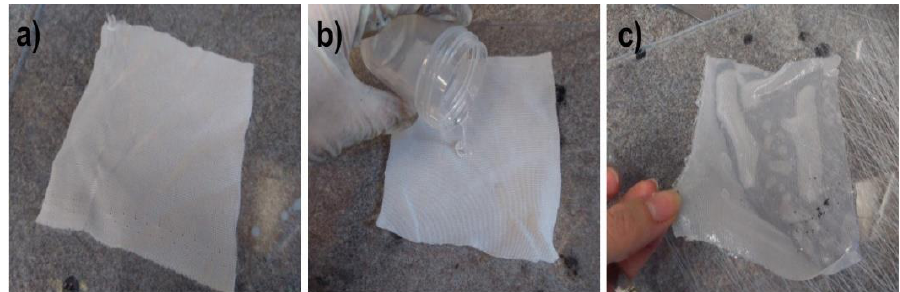
Figure 3. Preparation of PSi membranes for water vapor permeation studies. ( a ) Cotton squares 12 cm × 12 cm; ( b ) pouring PSi onto cotton fabric on a leveled glass plate; ( c ) samples ready for water vapor permeation studies.